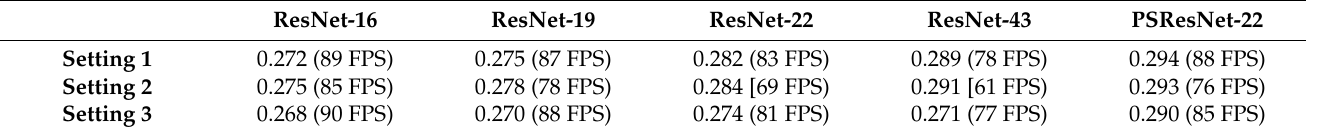
Table 6. Ablation over different channel pruning settings. The FPS represents